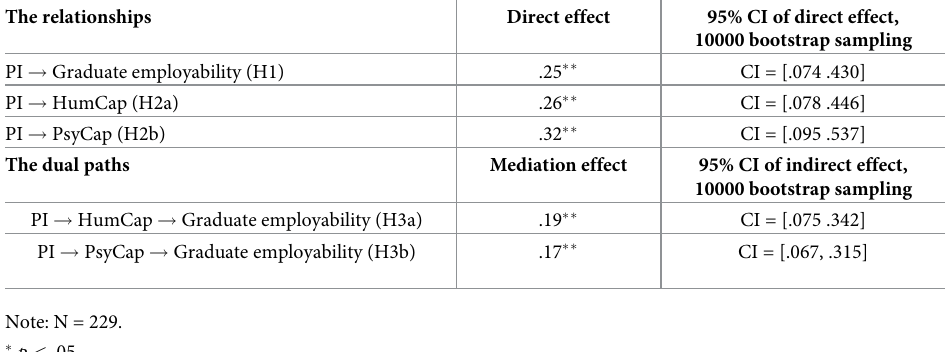
Table 4. The direct and mediation effects among PI, HumCap, PsyCap, and graduate employability. The relationships